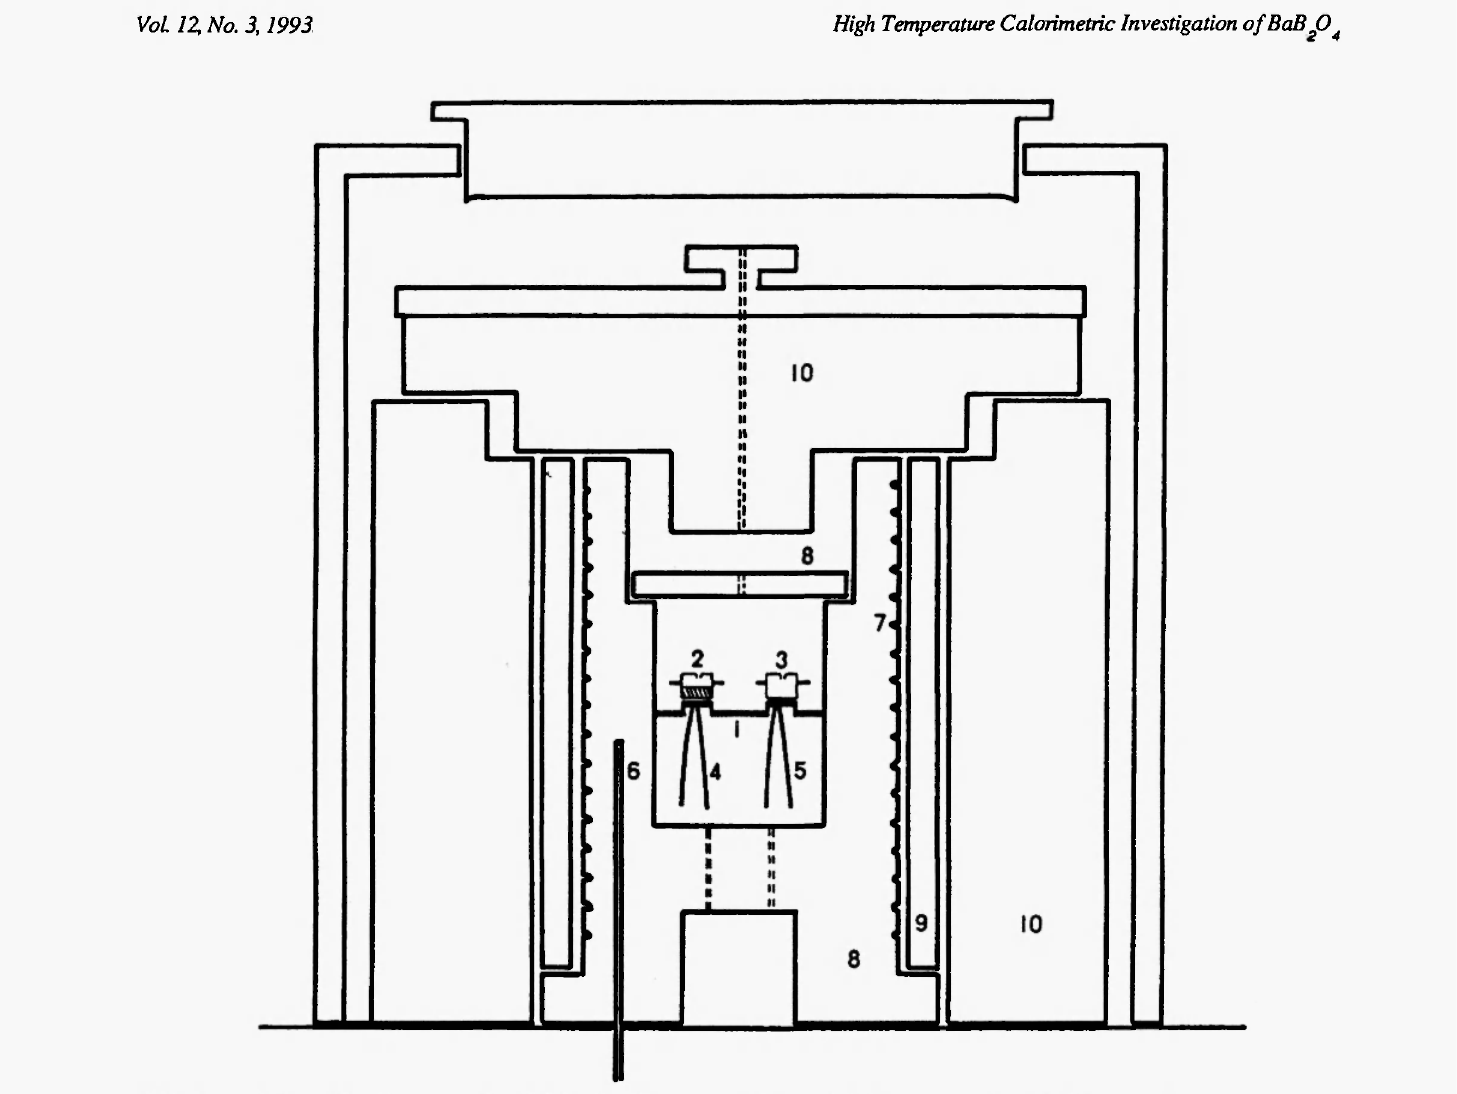
Fig. 2: Schematic diagram of a DSC chamber presently used. Three ceramic cylinders made of alumina (two inner sides) and aluminosilicate (outer side) are arranged in a concentric circle for adiabatic insulation. 1, heat sensor; 2, sample cell; 3, reference cell; 4, 5, 6, thermocouples; 7, Pt heater (0.8 mmc/>); 8,9, alumina cylinder; 10, aluminosilicate